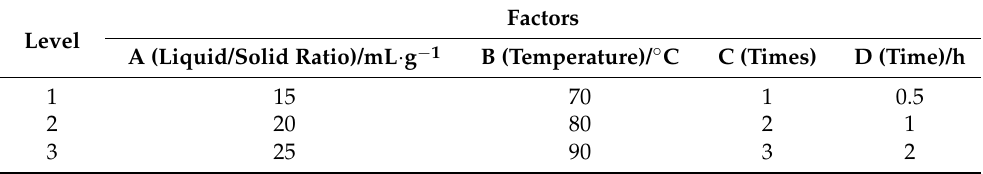
Table 1. Orthogonal design factor